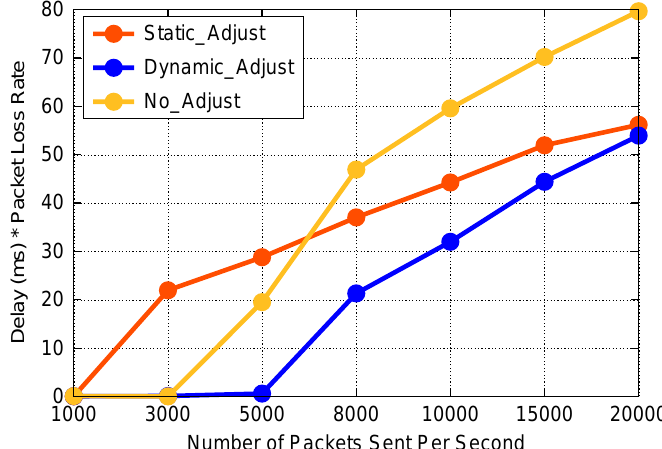
Figure 7. Delay * packet loss rate